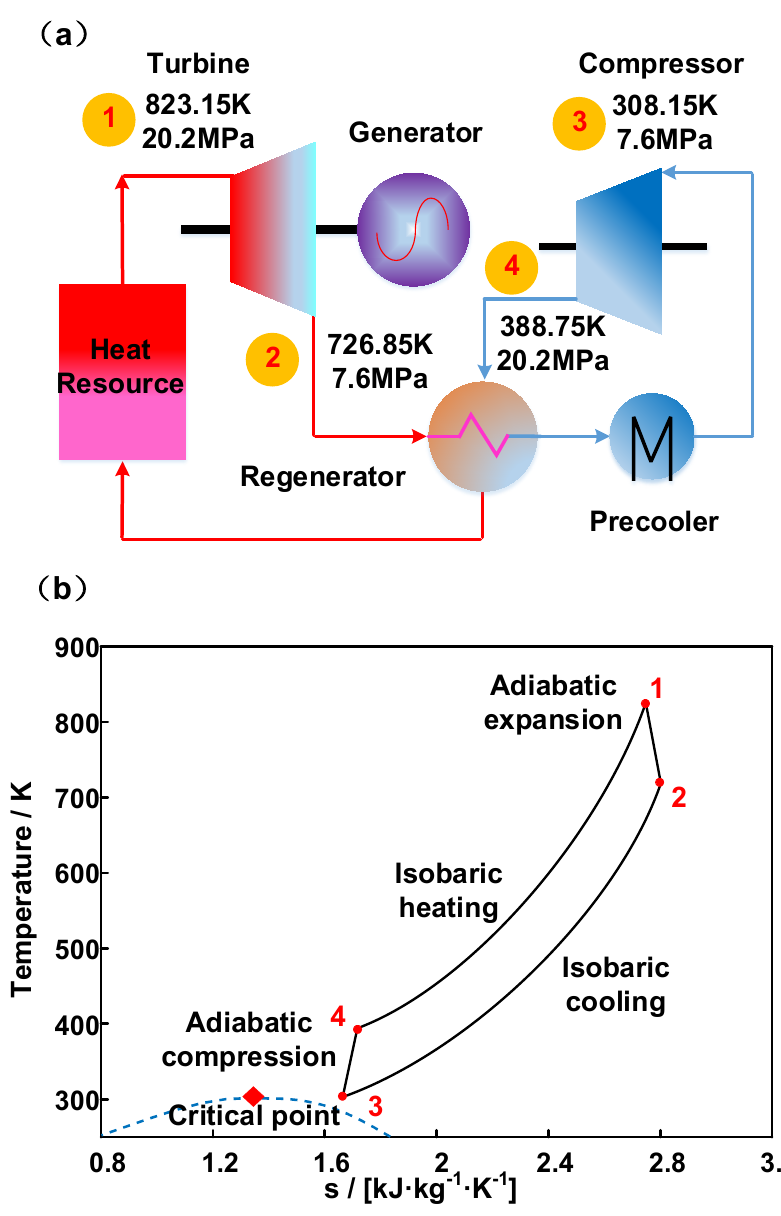
Figure 1. Diagrams of ( a ) a sCO 2 simple Brayton cycle process and ( b ) the T–s diagram. In this work, a counterflow double-channel PCHE model was established with two channels corresponding to the hot and the cold side. As shown in Figure 2, the channels have semicircular cross-sections with 2 mm diameters and a 0.5 mm space in between. The simulations are completed under the ANSYS software system, in which ICEM is used for meshing and Fluent is used for calculations. The unstructured tetrahedral mesh is divided and 10 bidirectional prism layers are generated in the wall boundary layer. The SST k-omega turbulence model is chosen due to the Reynolds number range and flow bending. The dimensionless y+ is set close to 1 to better reflect the influence of the boundary layer near the wall. Periodic boundary conditions were applied on the top, the bottom, the left, and the right sides, and adiabatic boundary conditions were applied on the front and the back surfaces. The inlet temperature and pressure boundary conditions on the hot and cold channels were 726.85 K, 7.6 MPa and 388.75 K, 20.2 MPa, respectively. Both are far away from the CO 2 critical point (304.25K, 7.38MPa). The inlet mass flow rate range on both sides is from 4.82 × 10 −4 to 14.45 × 10 −3 kg/s.